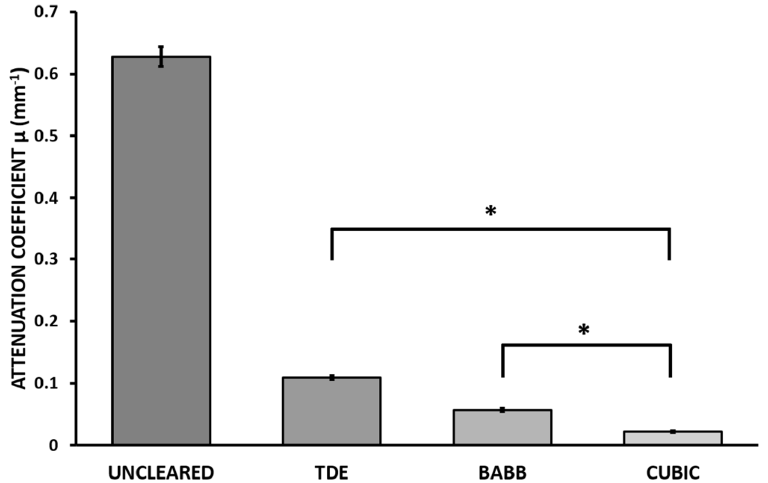
Figure 7. Final average attenuation coefficient values µ for each of the images obtained from uncleared, post-TDE incubation, post-BABB incubation, and post-CUBIC incubation melanoma xenograft samples (data represent mean ± SEM, * p < 0.001, one-way ANOVA plus Bonferroni post-test). 3.3. Hematoxylin & Eosin Staining and TEM Imaging of Cleared Human Melanoma